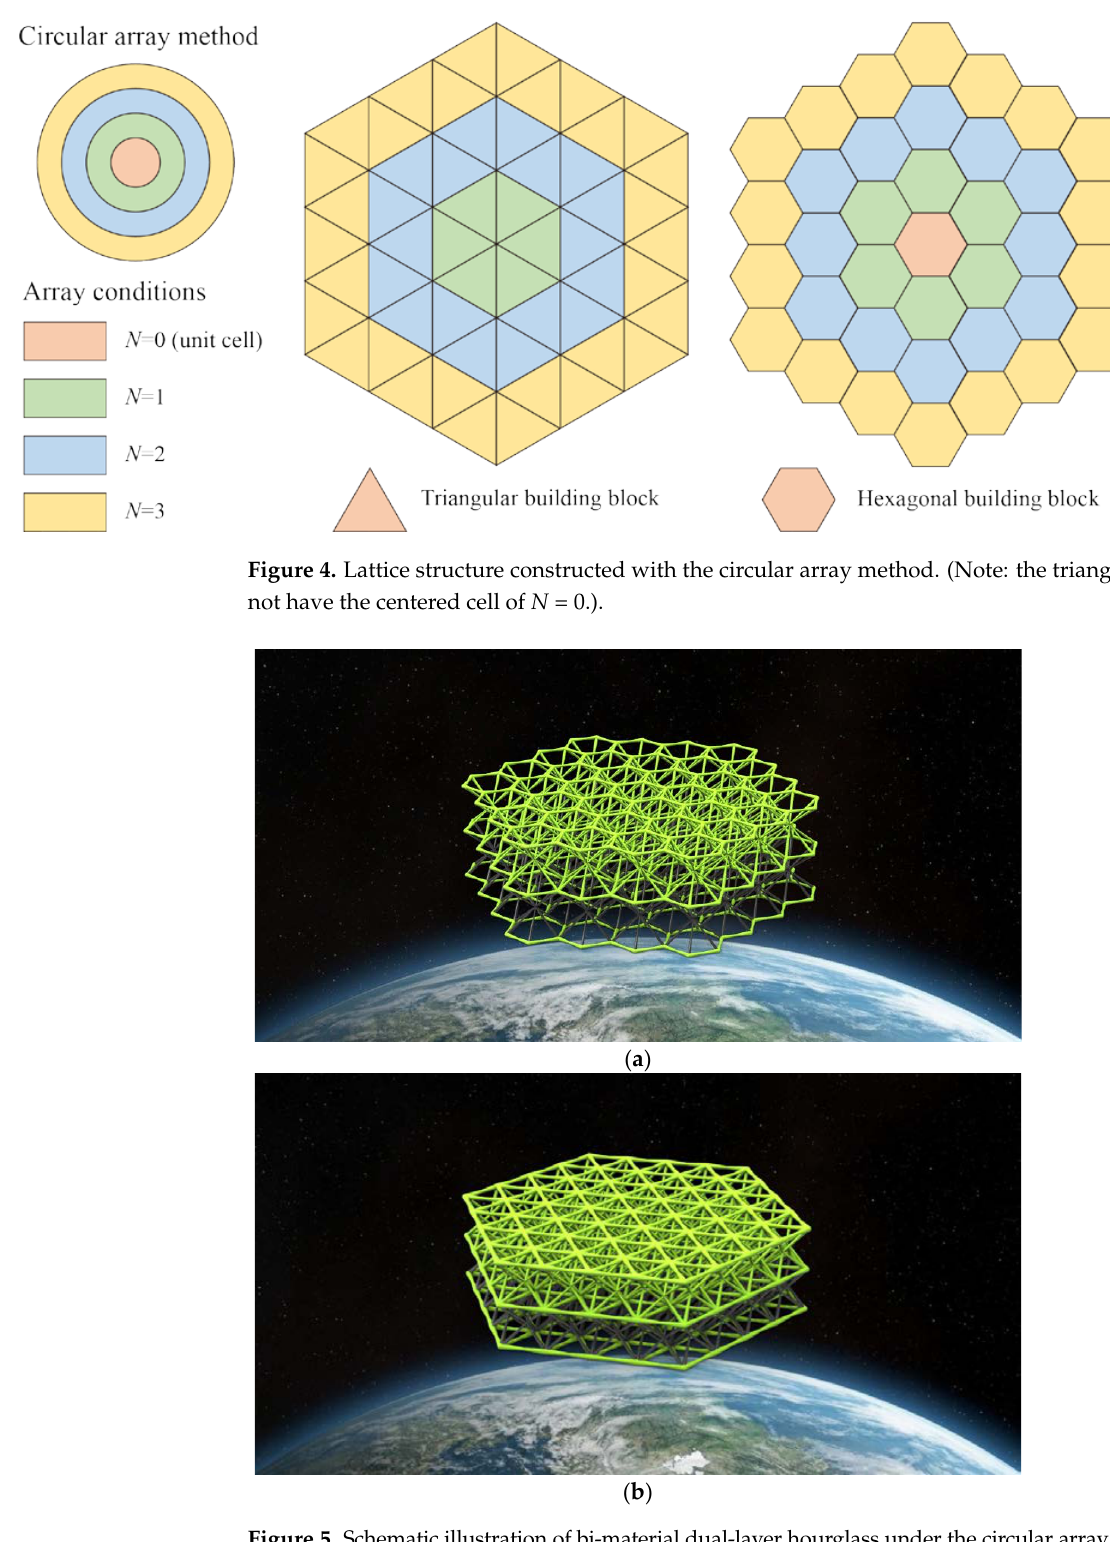
agon type; ( b ) triangle type. type; ( b ) triangle